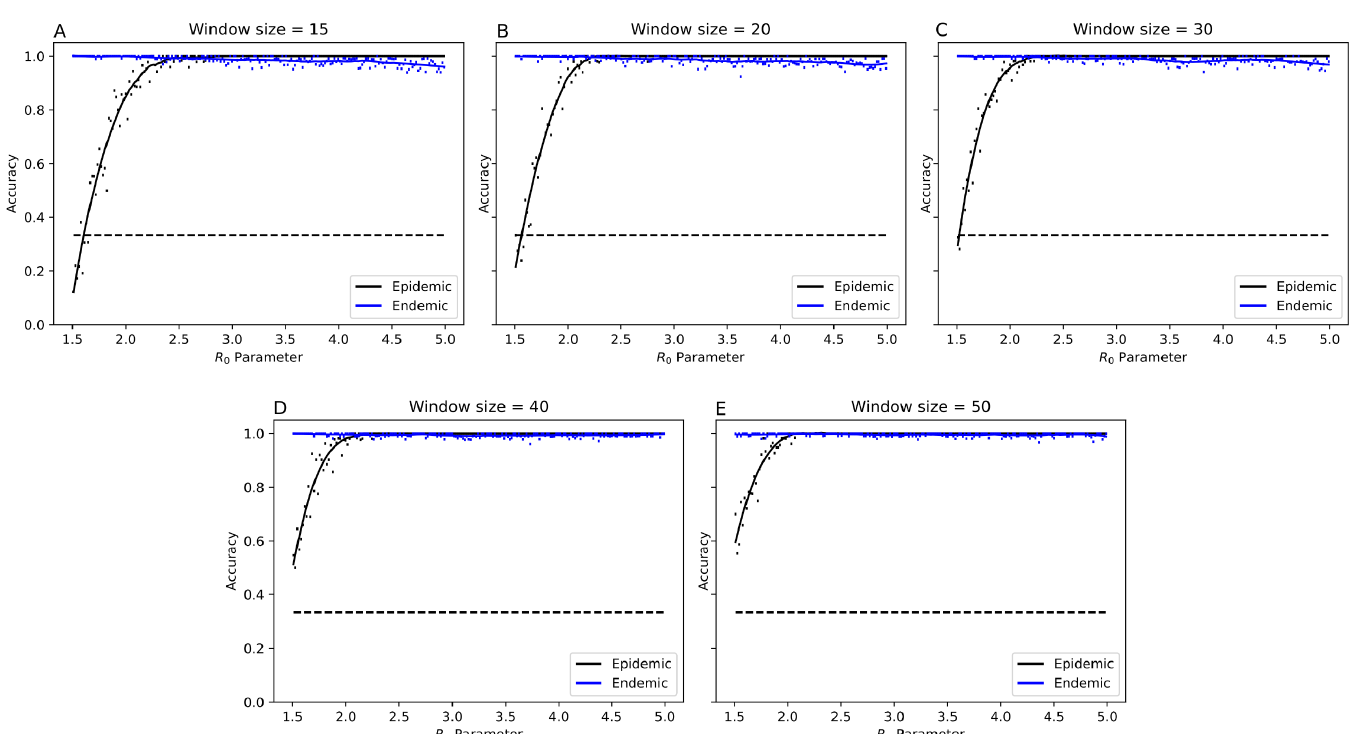
Fig 5. Association between R 0 parameter and per-image model performance by epidemic vs endemic training label. The R 0 axis is subdivided into 200 subintervals. Accuracy is calculated over each subinterval, a trend line is fitted using a Savitzky-Golay filter of degree 3 with a window size of 51. A black dashed line indicates the probability of predicting an outbreak using only the occurrence rate in the training set, independent of R 0 . Outbreaks with small R 0 are more difficult to detect than with larger R 0